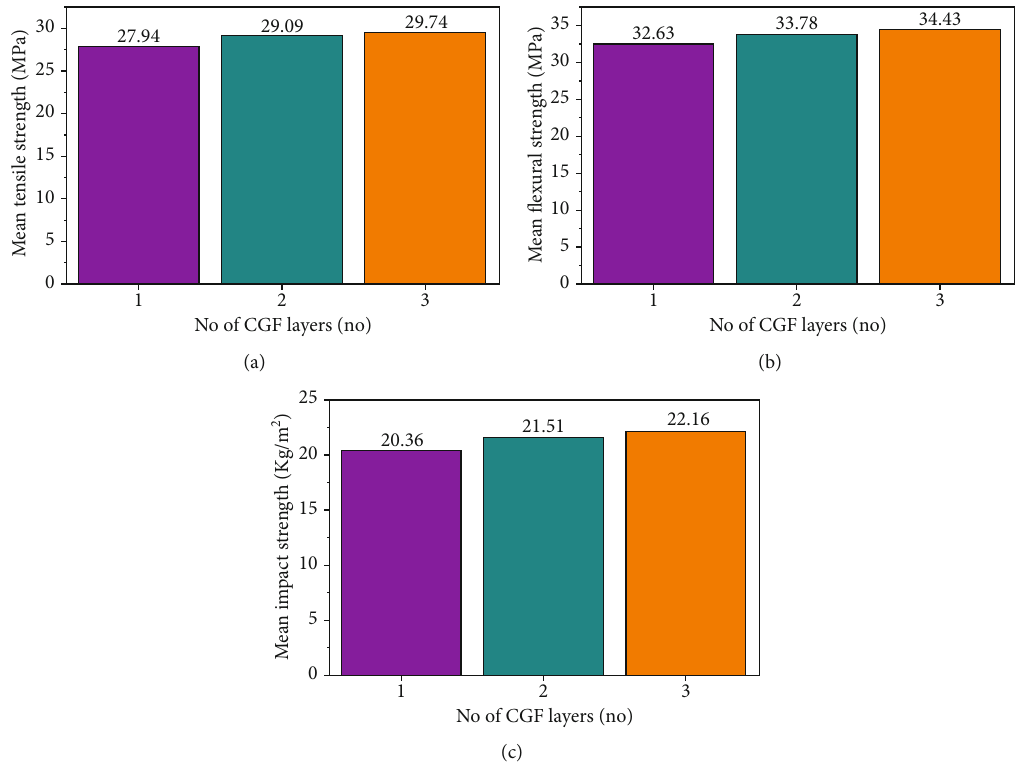
Figure 4: Result of woven CGF layer addition on the mechanical